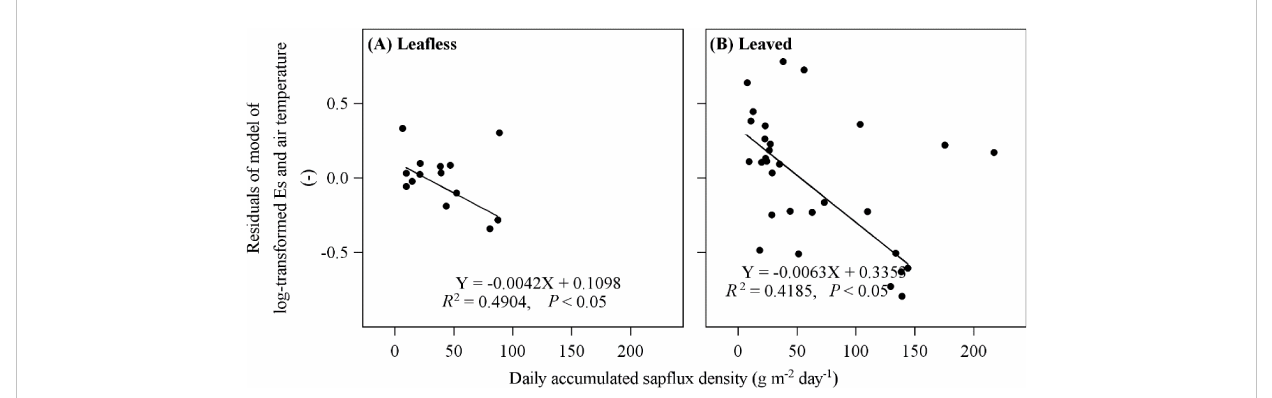
FIGURE 4 Relationship between daily accumulated sap fl ux density and residuals of the log-transformed stem-surface CO 2 ef fl ux ( E s ) model and air temperature in lea fl ess (A) and leaved (B) stages of the newly sprouted culms. One and two abnormal points were excluded from the regressions in lea fl ess (A) and leaved (B) stages,